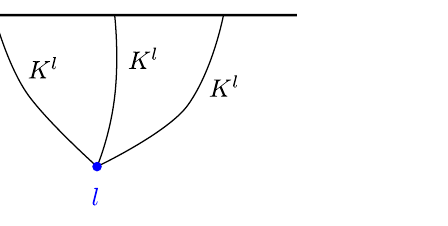
JHEP03(2022)023